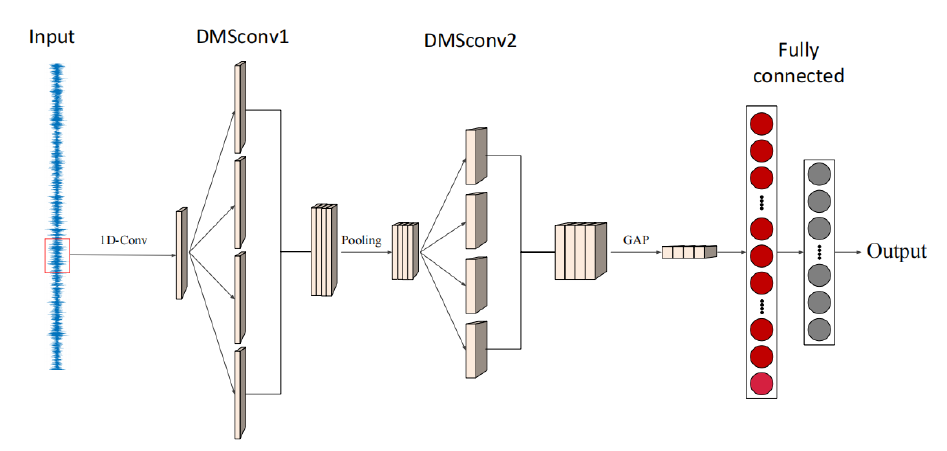
Figure 3. Structure of the proposed IMSCNN